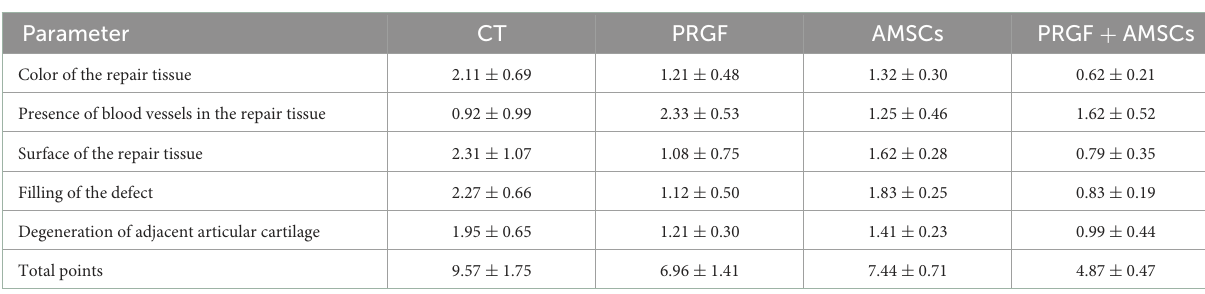
TABLE 3 Macroscopical scores 56 days after